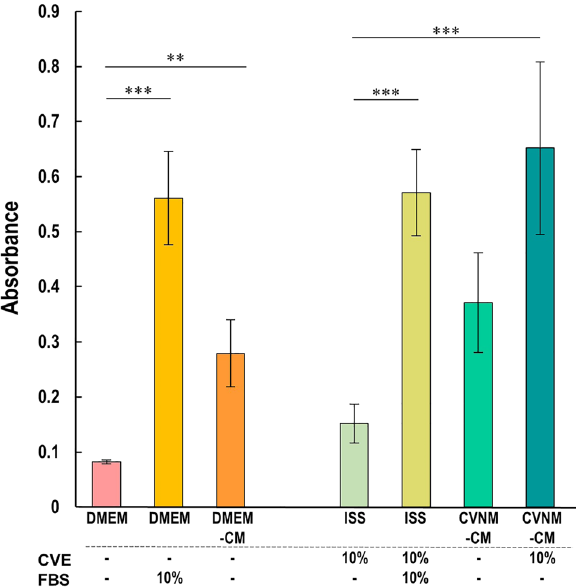
Figure 7. Proliferation of bovine myoblasts cultured with DMEM and CVNM for 2 days. The following media were used: DMEM, DMEM with 10% FBS, DMEM-CM, ISS with 10% CVE (10% CVNM; control for CVE- based media), 10% CVNM with 10% FBS, CVNM-CM, and CVNM-CM with 10% CVE. Data are presented as the mean ± standard deviation (n = 3). Statistical analysis was performed on the data set in Supplementary Fig. S1. *** P < 0.001, ** P < 0.01 . CVE, Chlorella vulgaris extract; CVNM, C. vulgaris -derived nutrient